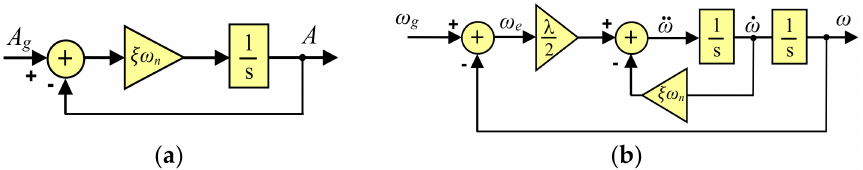
Figure 2. Linearized models of the SOGI-FLL: ( a ) estimated voltage amplitude; ( b ) estimated voltage